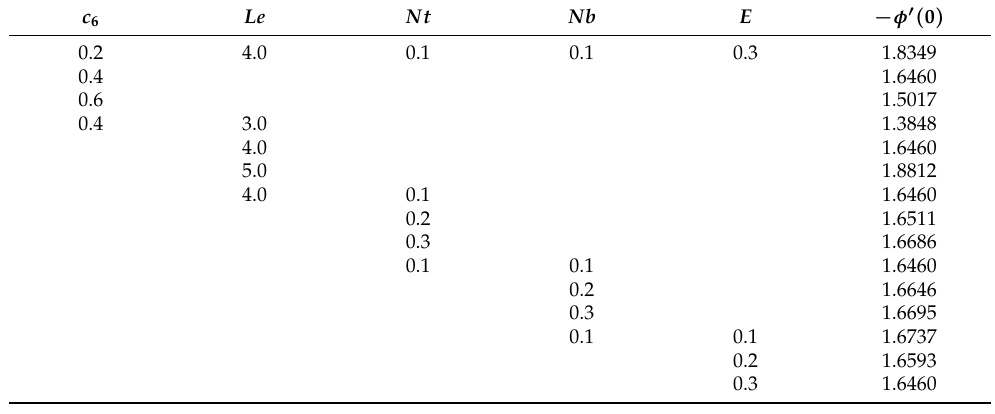
Table 4. Results for − φ (cid:48) ( 0 ) .